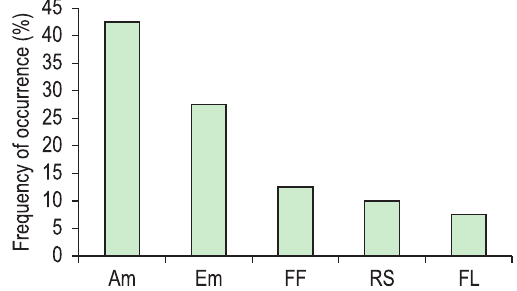
Figure 4. Ranking of biological forms occurrent in the basin of the Apodi/Mossoró River, RN, Northeast Brazil. Am = Amphibian; Em = Emergent; FF = Free-floating; RS = Rooted-submersed; FL =